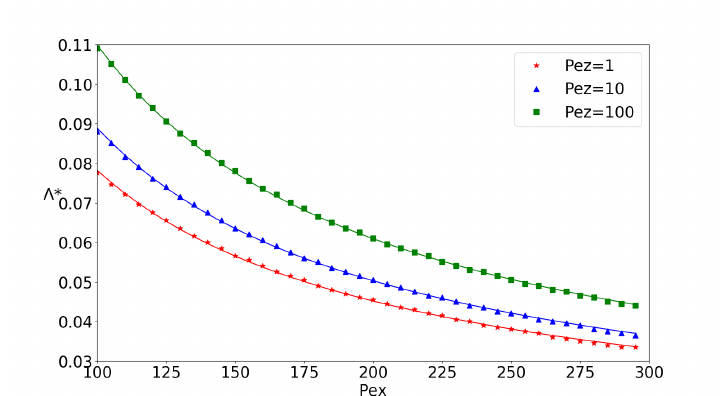
Figure 12. Dimensionless width ( Λ ∗ = Λ / L ) of the region where the error due to the inconsistent boundary conditions on the departure boundary is significant as a function of the horizontal Peclet number ( Pe x ) for various values of the vertical Peclet number, that is, Pe z =